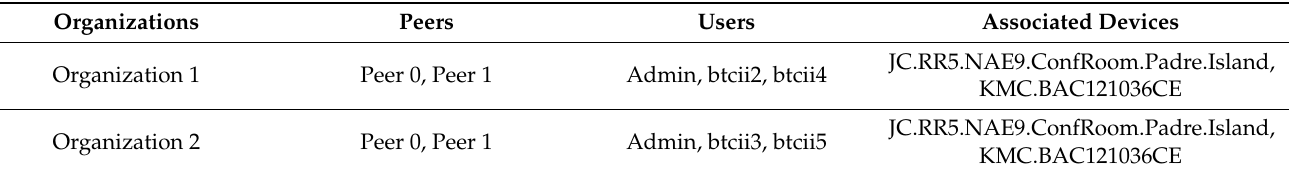
Table 5. Summary of fabric’s artefact and associated